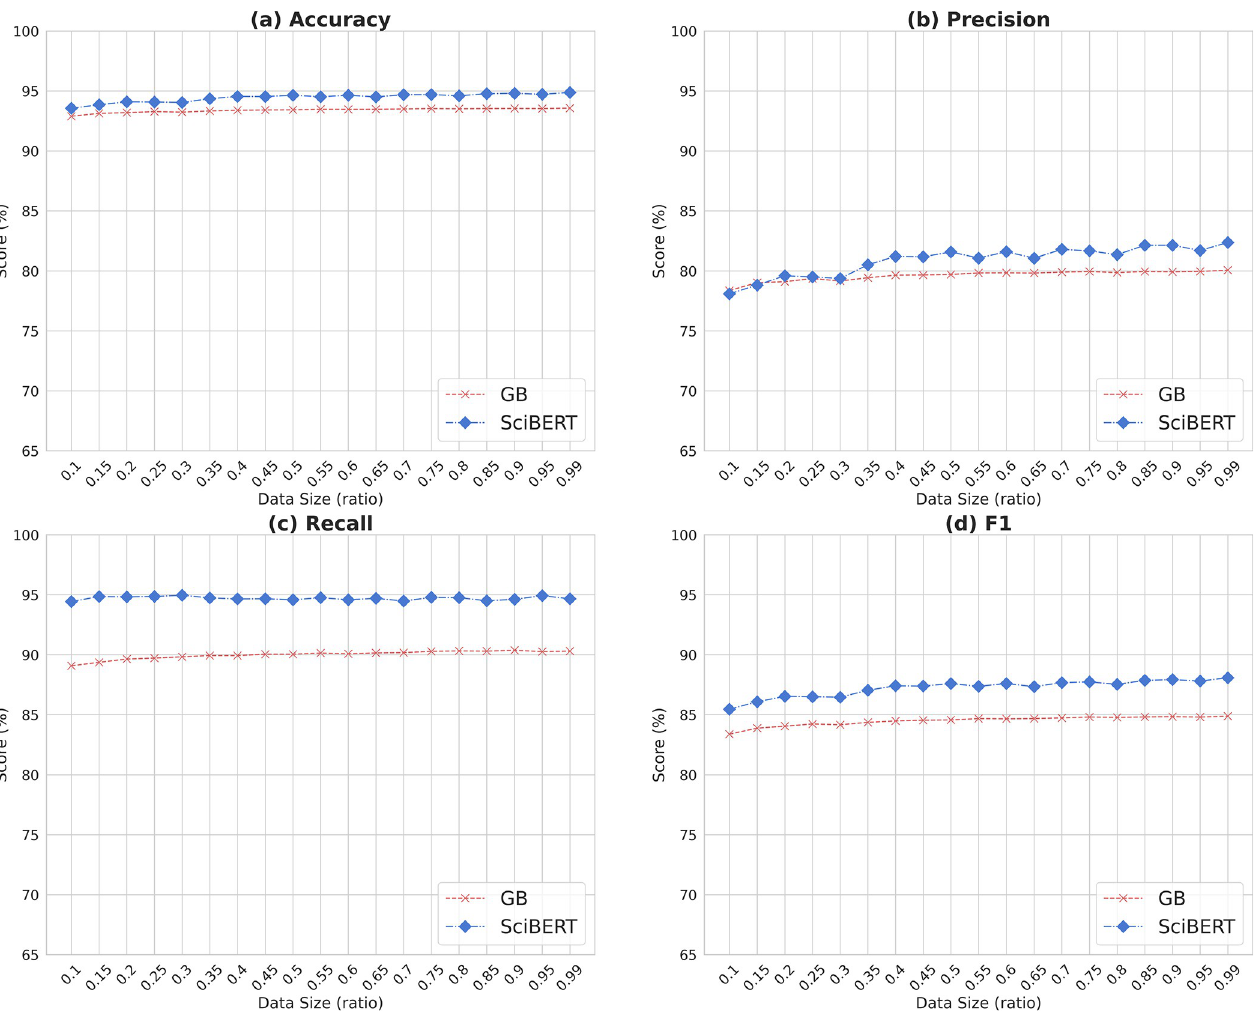
Fig 2. Distribution of average scores of four evaluation metrics for a conventional machine learning model (GB: Gradient Boosting) and a BERT-based model (SciBERT) based on training data size change after balancing class to 1:1.